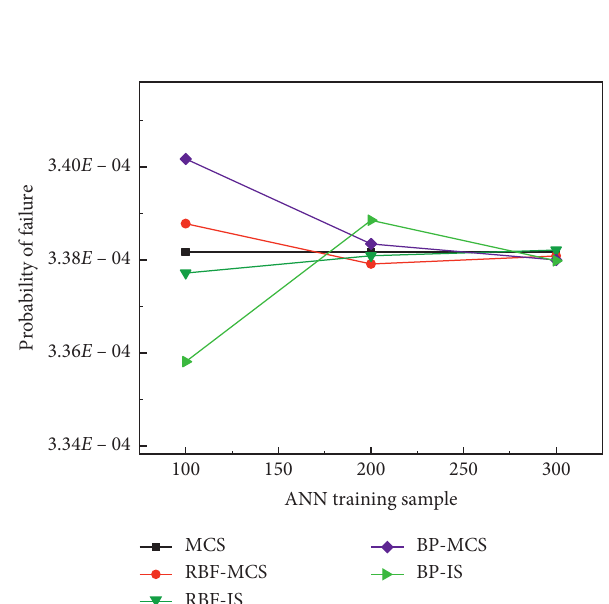
Figure 9: Comparison of the POF between ANN-IS (RBF-IS and BP-IS) and various other methods relative to ANN sample data size.